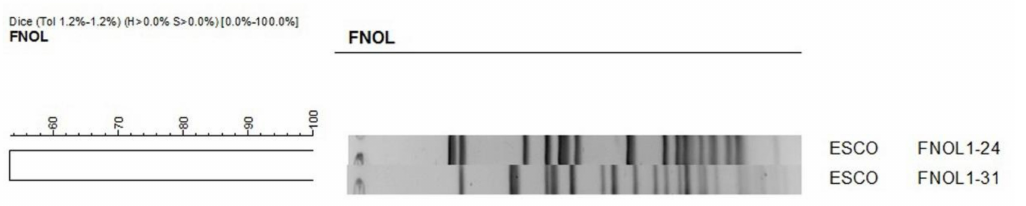
Figure 3. PFGE of 2 CTX-M-15-positive Escherichia coli